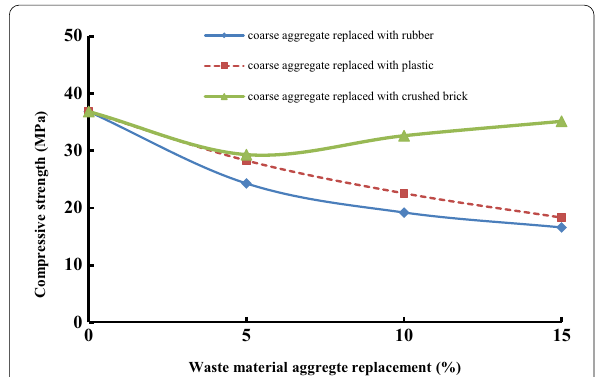
Fig. 7 Compressive strength of concrete with different types of waste material.